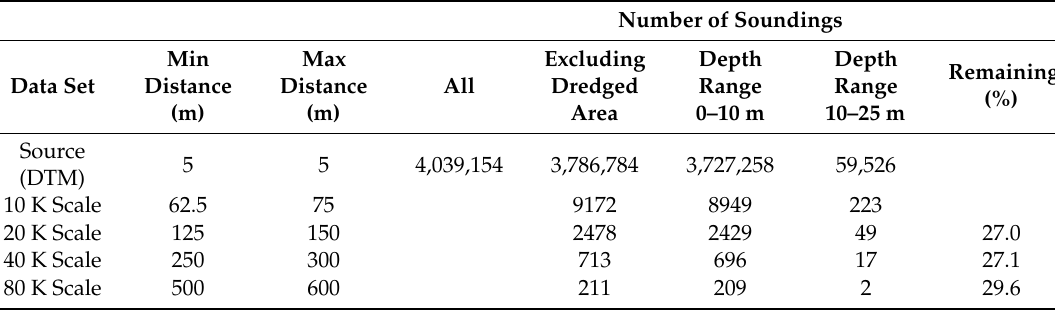
Table 4. Soundings generalization across